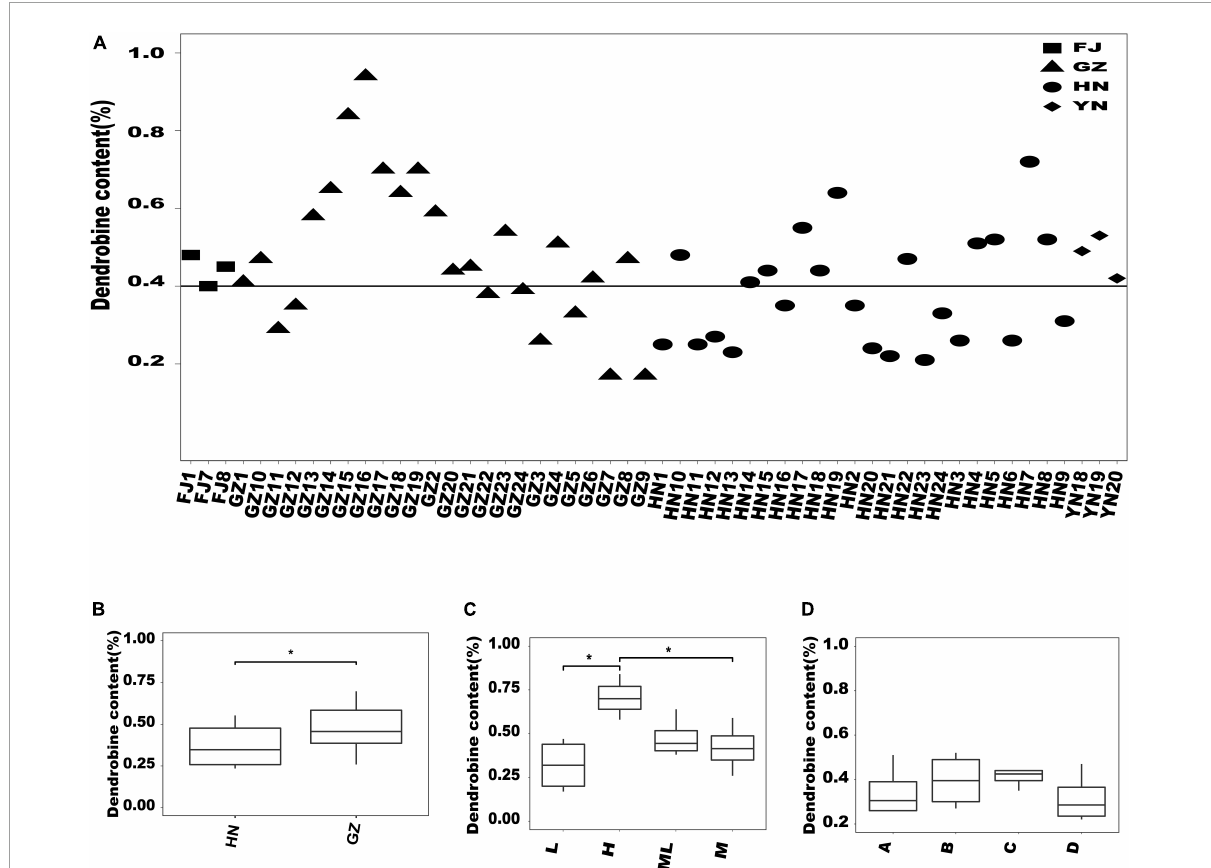
FIGURE5 Analysis of the dendrobine content in Dendrobium nobile from different habitats. (A) Distribution of the dendrobine content of all samples; (B) comparison of the dendrobine content between HN and GZ; (C) comparison of the dendrobine content at different altitudes in GZ area. L, low altitude (327 m); H, high altitude (692 m); ML, middle-low altitude (484 m); M, middle altitude (528 m). *0.01 < P < 0.05; (D) comparison of dendrobine contents in different epiphytic substrates at the same altitude in HN producing area. A, areca catechu; B, litchi chinensis; C, jackfruit tree; and D,